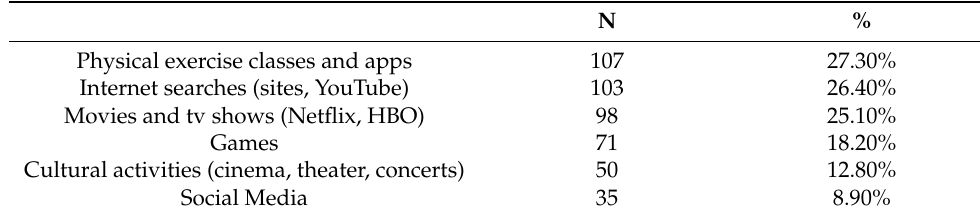
Table 3. Categories of on-line activities for